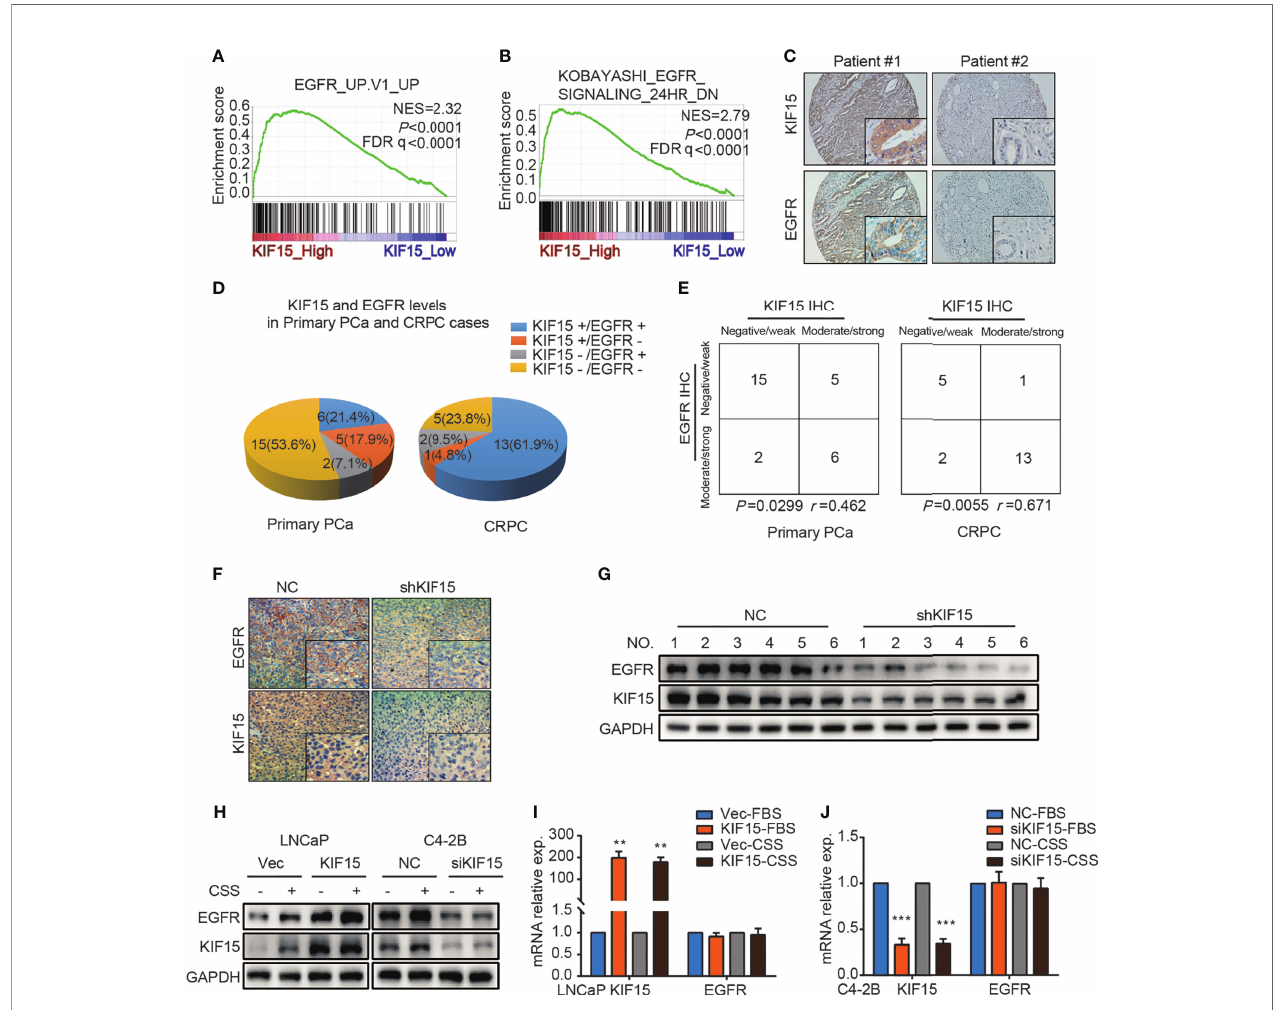
FIGURE 3 | KIF15 promotes EGFR expression in PCa. (A) GSEA analysis of EGFR signatures (genes upregulated upon EGFR elevated) from a microarray dataset (GSE35988) that pro fi led CRPC cases with KIF15_High (the highest 2 samples) or KIF15_Low (the lowest 2 samples) expression. NES = 2.32; P < 0.0001, FDR q < 0.0001. (B) GSEA analysis of EGFR signatures (down-regulated after treatment with EGFR inhibitor) from a microarray dataset (GSE32269) that pro fi led CRPC cases with KIF15_High (the highest 2 samples) or KIF15_Low (the lowest 2 samples) expression. NES = 2.79; P < 0.0001, FDR q < 0.0001. (C, D) Representative IHC images (C) and quantitative analysis (D) for EGFR and KIF15 expression in PCa cases in Qilu Hospital. KIF15-, negative and weak KIF15 positive tumors examined by IHC staining; KIF15+, moderate and strong KIF15 positive tumors examined by IHC staining; EGFR-, negative and weak EGFR positive tumors examined by IHC staining; EGFR+, moderate and strong EGFR positive tumors examined by IHC staining. (E) Contingency table for KIF15 expression and EGFR status by IHC in primary PCa cases and CRPC cases in Qilu Hospital. (F, G) EGFR protein expression in C4-2B xenograft examined by IHC staining (F) and Western blot (G) . (H) EGFR protein expression in LNCaP cells (left) and C4-2B (right) cells. These cells were cultured and passaged in CSS medium or FBS medium for 1 month, and then they were transfected with corresponding expression plasmids for 48 hours or siRNA for 72 hours. Then cells were collected, lysed for Western blot assay. (I, J) The relative mRNA expression of KIF15 and EGFR in LNCaP (I) and C4-2B (J) cells with indicated treatment. LNCaP (I) and C4-2B (J) cells with indicated treatment as (H) were transfected with expression plasmids or siRNAs for 48 hours. The total RNA was extracted, and the mRNA levels of KIF15 and EGFR were determined by qRT-PCR. ** P < 0.01; *** P <